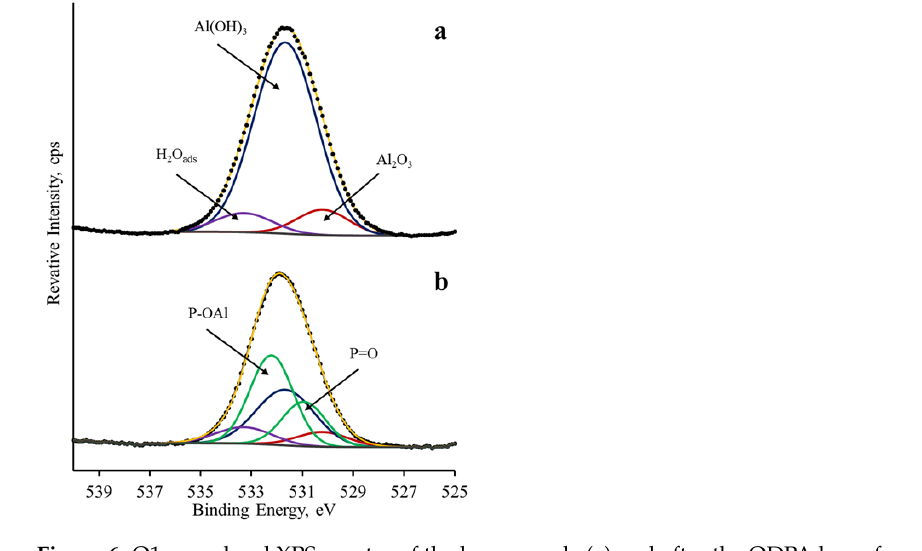
Figure 6. O1s core level XPS spectra of the bare sample ( a ) and after the ODPA layer formation ( b ). Table 5. The atomic concentrations (%) of the oxide and hydroxide states of the bare sample (1) and after the ODPA layer formation